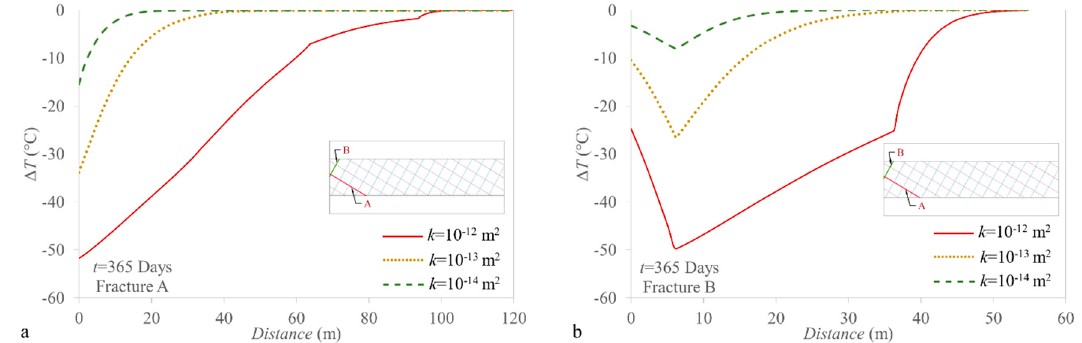
Figure 6. Temperature evolution along the fractures near to the injection point when fluid is injected 50 °C cooler than the reservoir temperature during 1 year, for ( a ) fracture A and ( b ) fracture B.